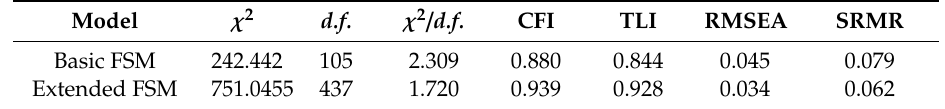
Table 3. Goodness-of-fit test for the basic and extended FSM